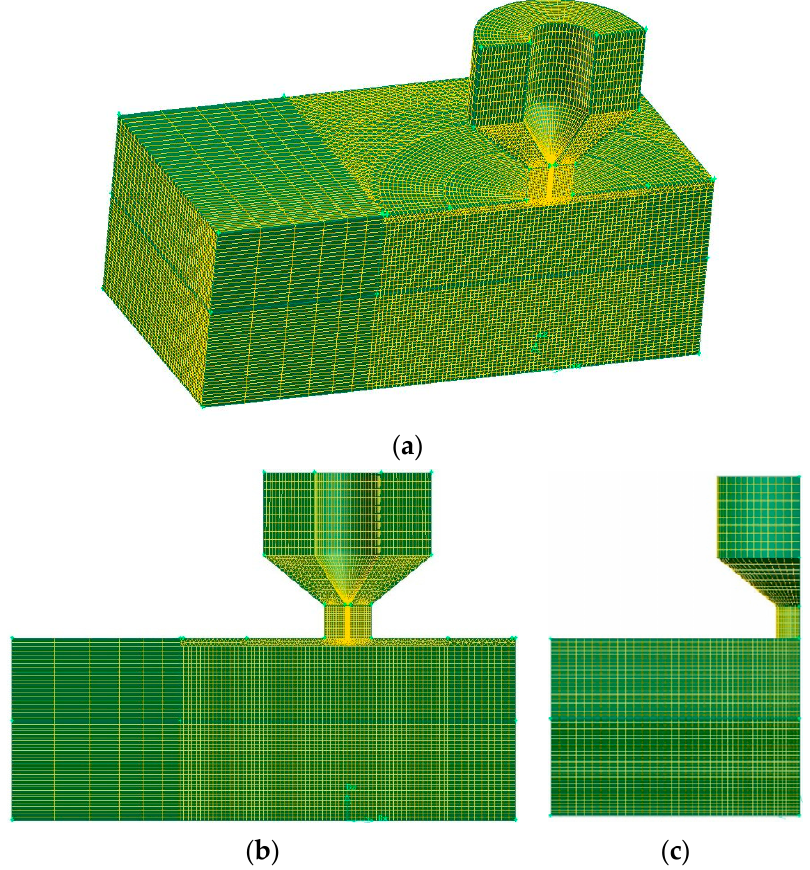
Figure 4. Grid system of the unified model. ( a ) Overall grid map; ( b ) Front-view grid ( x-z plane); ( c ) Side-view grid ( y-z plane).